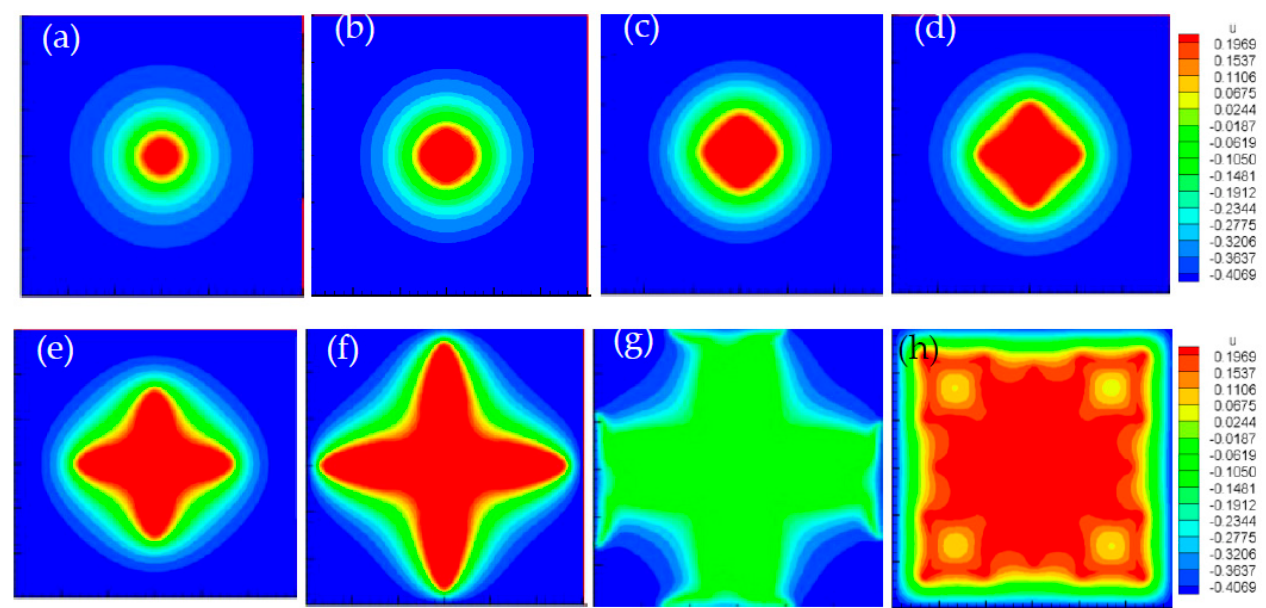
Figure 2. Δ t = 45,000. The undercooling is ( a ) Δ = − 0.15; ( b ) Δ = − 0.25; ( c ) Δ = − 0.35; ( d ) Δ = − 0.45; ( e ) Figure 2. ∆ t = 45,000. The undercooling is ( a ) ∆ = − 0.15; ( b ) ∆ = − 0.25; ( c ) ∆ = − 0.35; ( d ) ∆ = − 0.45; Δ = − 0.55; ( f ) Δ = − 0.65; ( g ) Δ = − 0.75; ( h ) Δ = − 0.85. Crystal temperature field topography. ( e ) ∆ = − 0.55; ( f ) ∆ = − 0.65; ( g ) ∆ = − 0.75; ( h ) ∆ = − 0.85. Crystal temperature field topography.